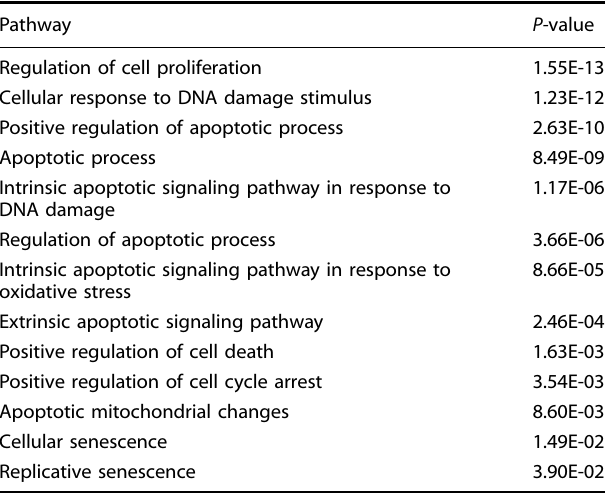
Table 1. Chondrocytes were treated with IL-1 β for 24 h. RNA sequencing was performed and signi fi cantly altered pathways are